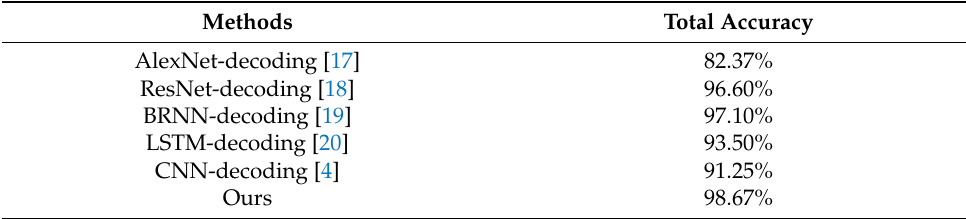
Table 7. Comparison of experimental results (accuracy,